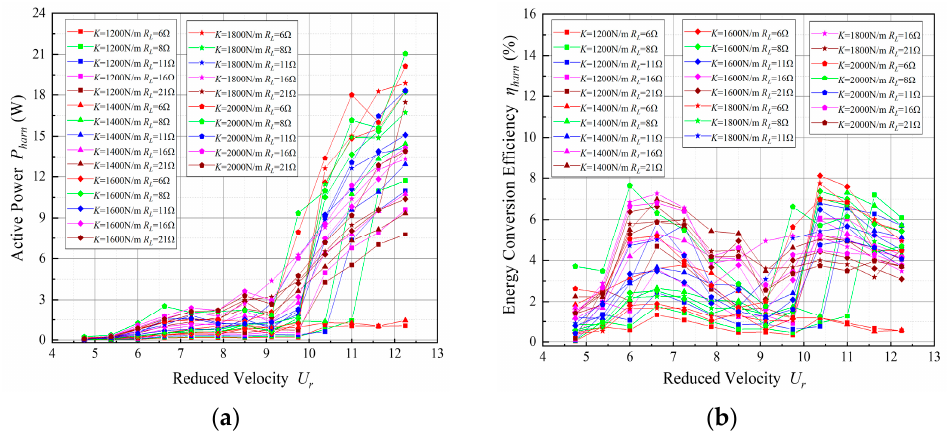
Figure 19. Active power and energy conversion efficiency for L / D = 4. ( a ) Active power; ( b ) Energy conversion efficiency.